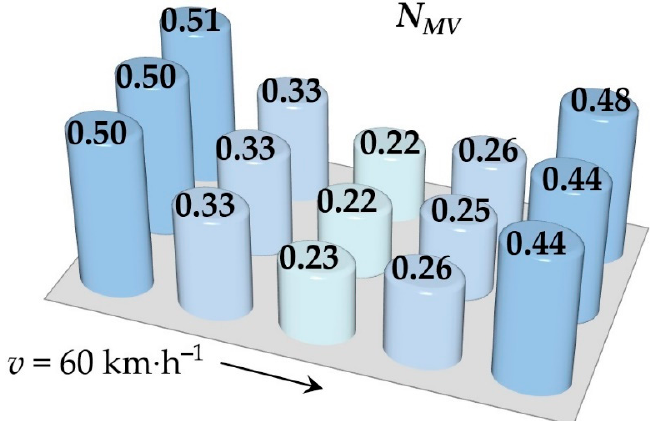
Figure 12. The distribution of the index N MV for a speed of 110 km · h − 1 : the “Modification I” parameters.